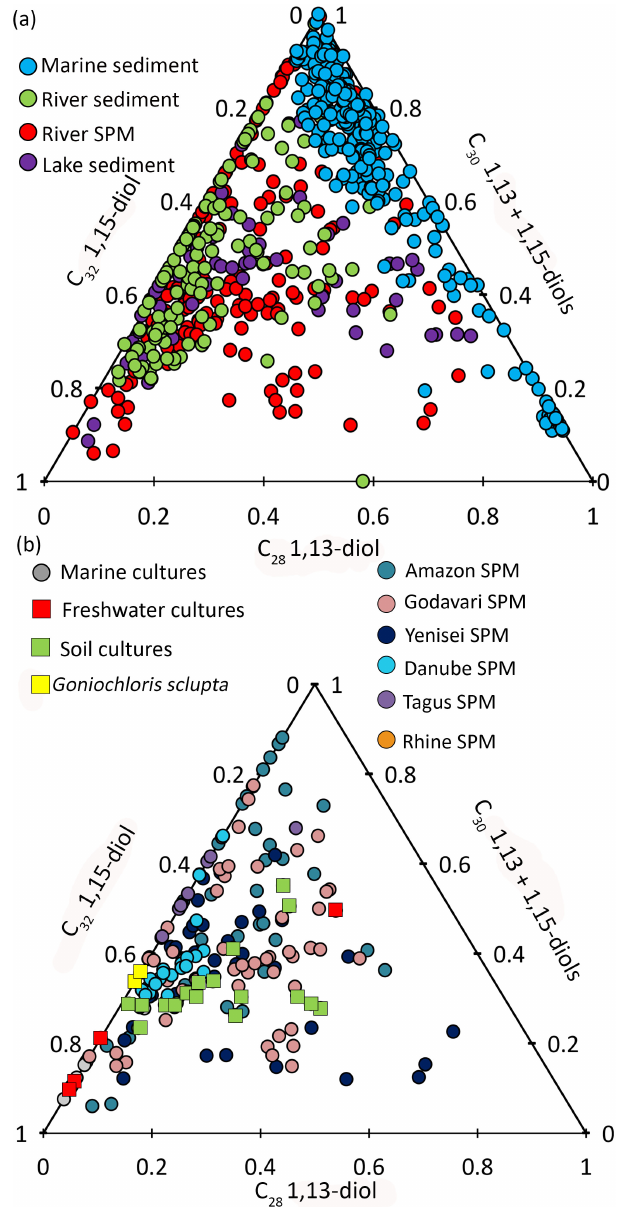
Figure 4. Ternary plot (C 28 1,13-diol; C 30 1,13- and C 30 1,15- diols; C 32 1,15-diol) of (a) marine sediments (from Rampen et al., 2012; De Bar et al., 2016; Lattaud et al., 2017b), river sediments (this study, Lattaud et al., 2017a), lake sediment (from Rampen et al., 2014b), river SPM (this study, Lattaud et al., 2017a), (b) cul- tivated algae (Rampen et al., 2014b), and river SPM (this study, Lattaud et al.,